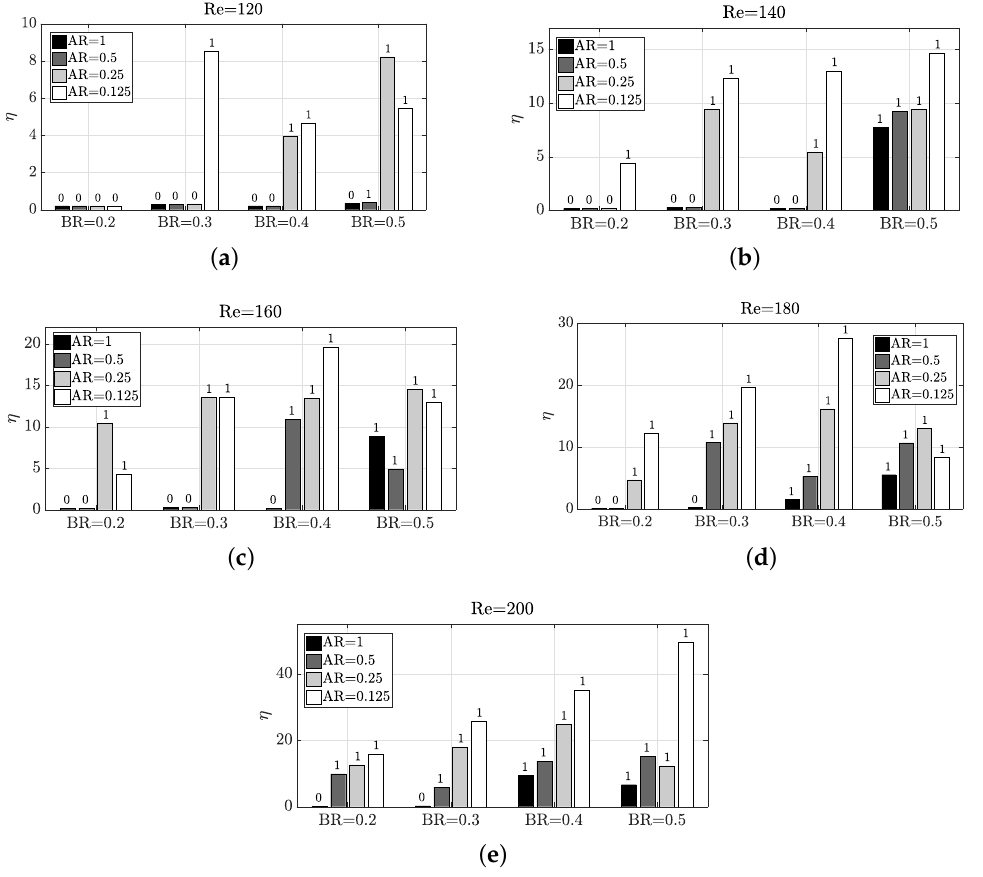
Figure 7. Impact of Reynolds number and geometry on thermal mixing efficiency η . The number on top of each bar indicates whether the configuration presents vortex shedding (1) or not